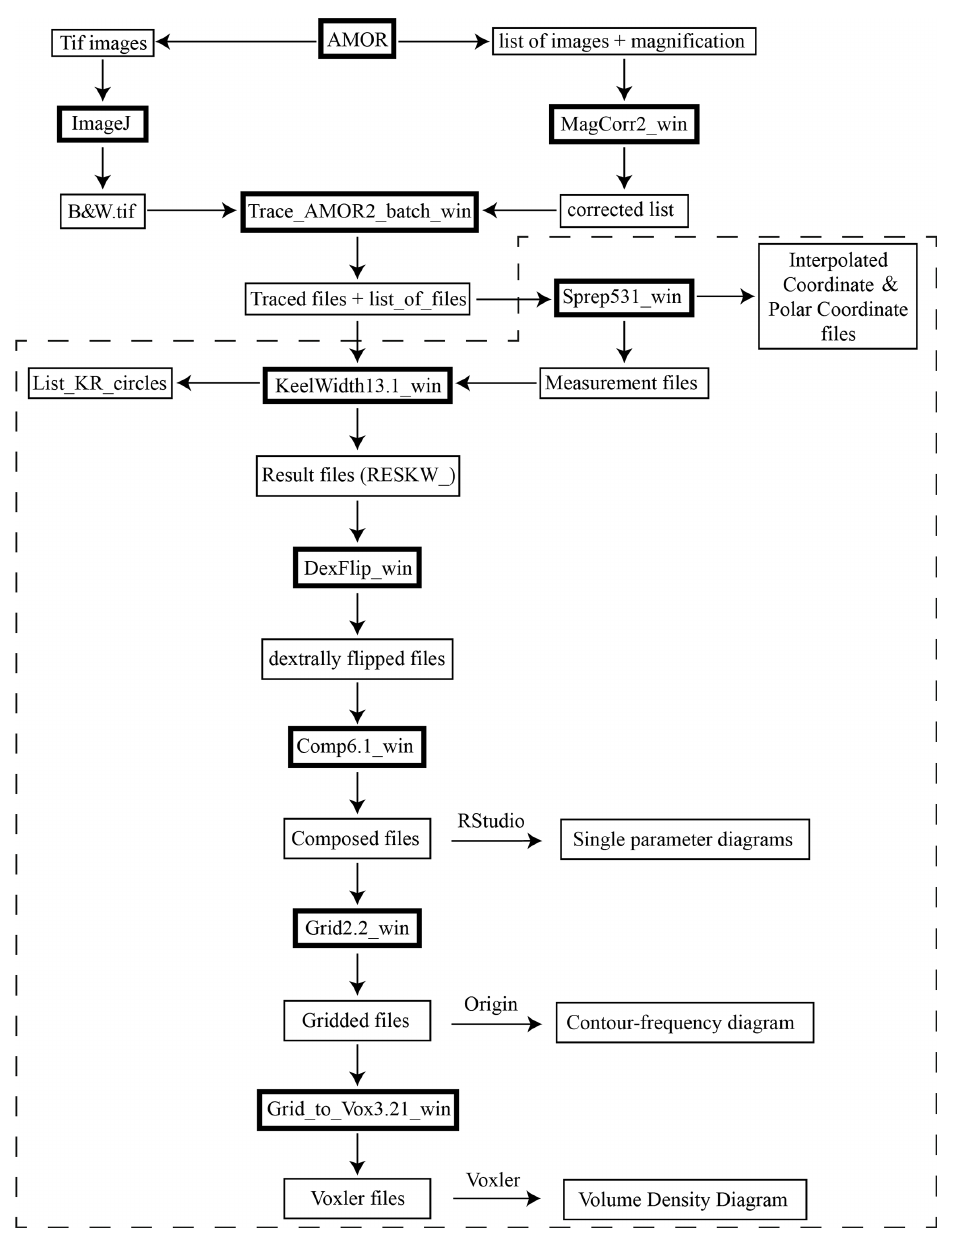
Figure A1. Flow chart of MorphCol programmes used. The dashed frame indicates processing steps after sorting of files with respect to species, number of chambers in the final whorl and coiling